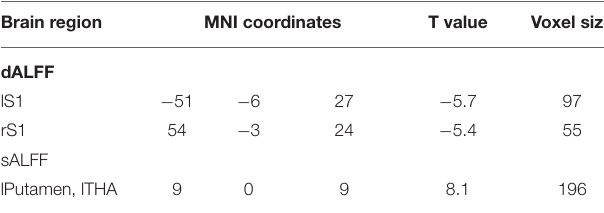
TABLE 2 | The dALFF and sALFF differences between DCM patients and healthy